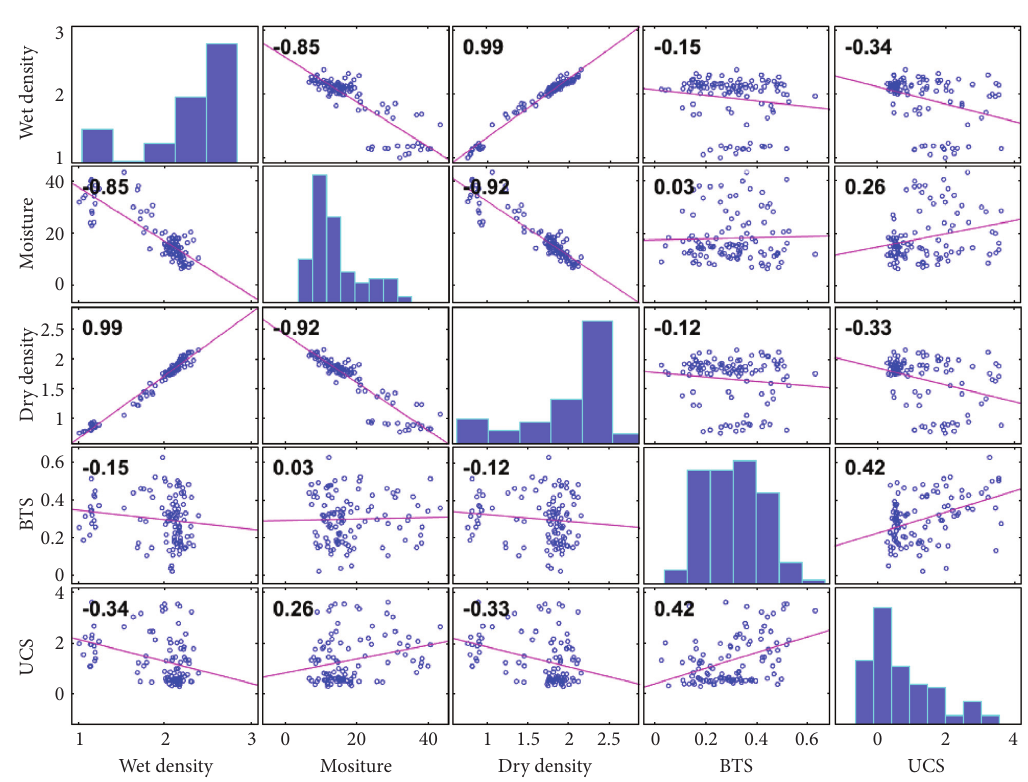
Figure 4: Pairwise correlation between the input variables and output in the original